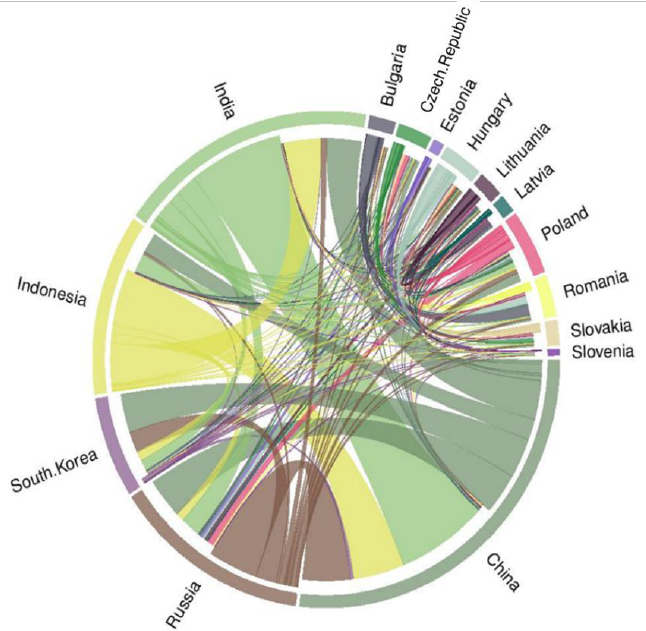
Figure 3. Interlinked relations of water use between the fifteen economies in trade (excluding RoW).